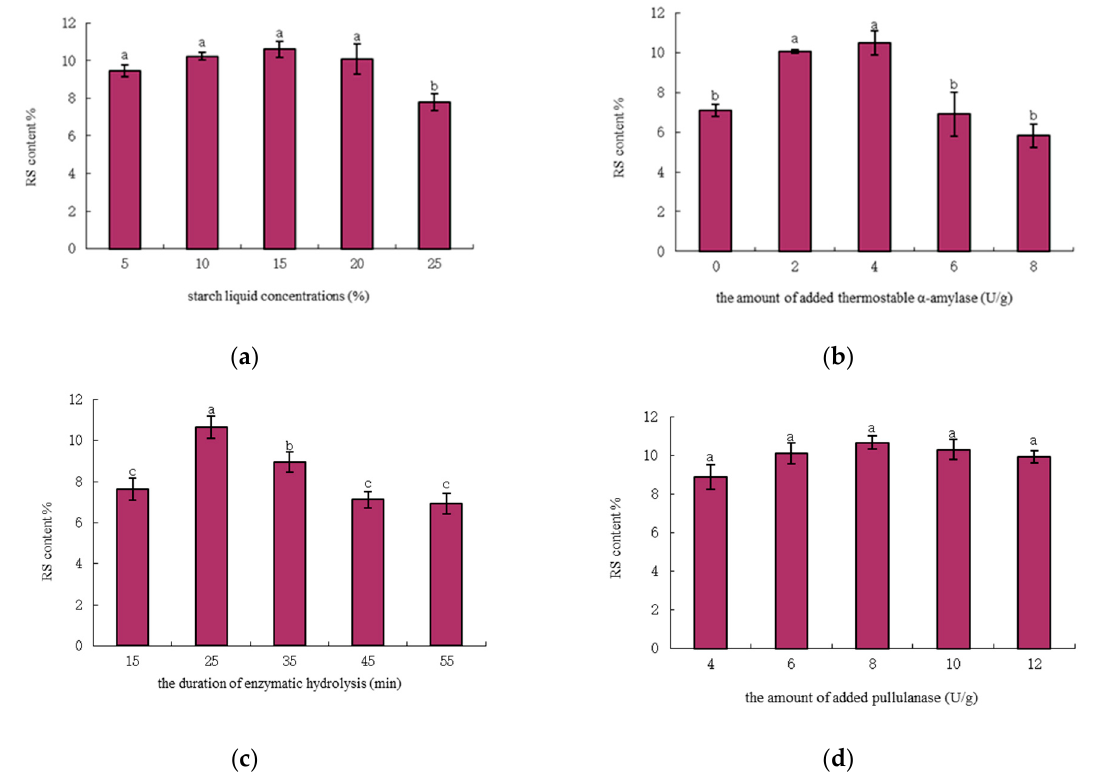
Figure 1. Effect of starch liquid concentrations ( a ), the amount of added thermostable α -amylase ( b ), the duration of enzymatic (thermostable α -amylase) hydrolysis ( c ) and the amount of added pullulanase ( d ) on RS content. Values with different letters in the same graph are significantly different ( p < 0.05).